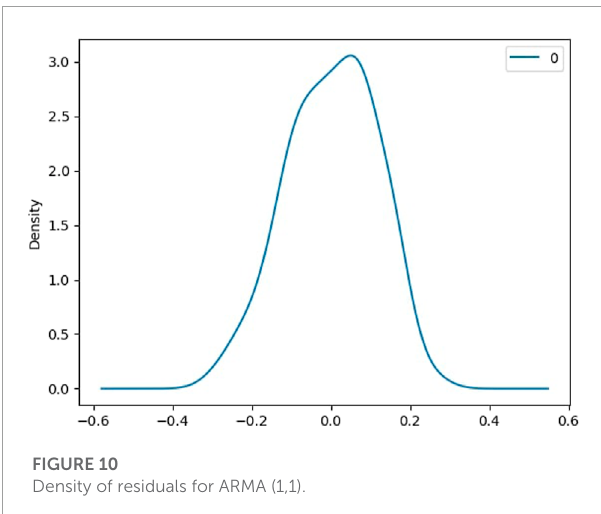
FIGURE 10 Density of residuals for ARMA